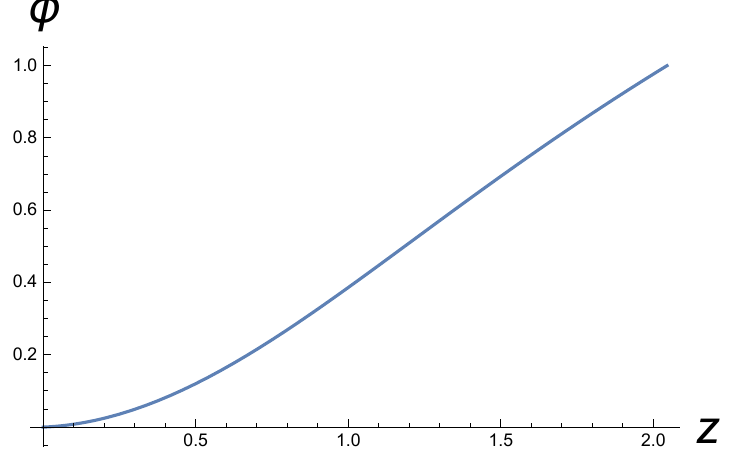
Figure 1 . The dilaton profile φ ( z ) interpolating the horizon z = z h ’ 2 . 044 to the AdS boundary √ z = 0 for a = 6 / 5 , m = 2 / 3 , Q A = 1 , φ 0 = 1 , and C = 0